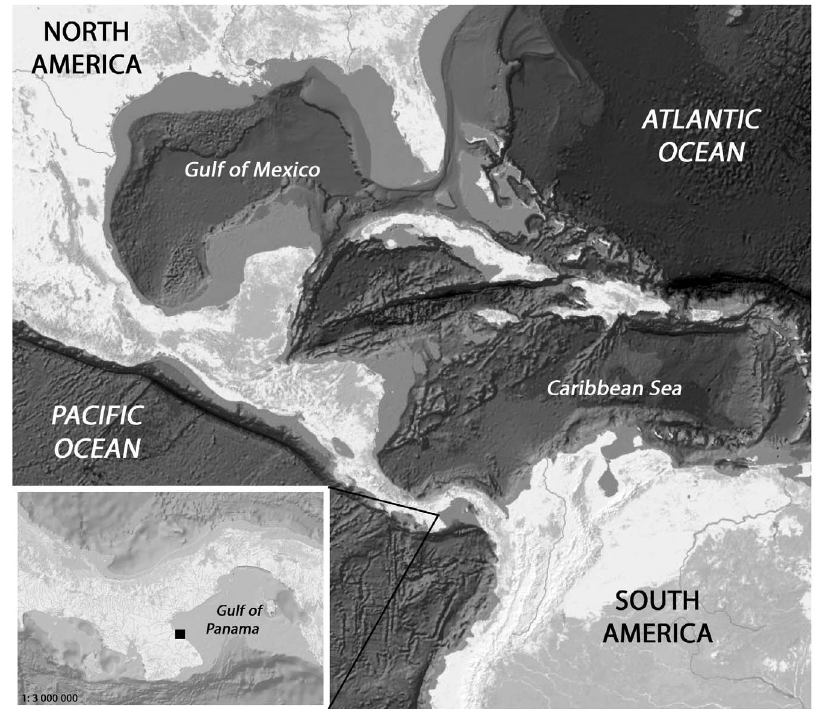
Figure 1. Location of the sampling site on the coast of